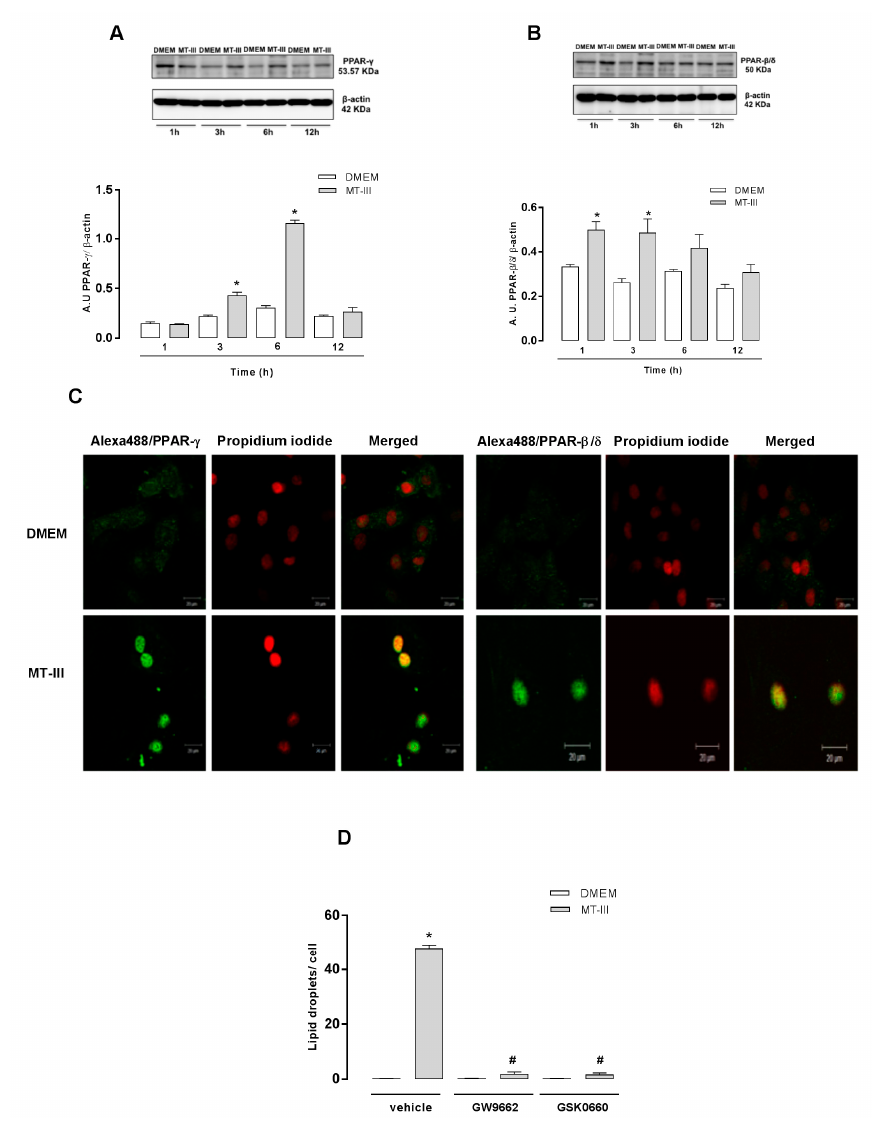
Figure 6. MT-III induces activation and upregulation of PPAR- γ and PPAR- δ / β expression in VSMCs. VSMCs (5 × 10 4 cells / well) were stimulated with MT-III (0.4 µ M) or DMEM (control) for 1, 3, 6, and 12 h. ( A , B ) Western blotting and densitometric analysis of PPAR- γ or PPAR- δ / β and β -actin (loading control) in VSMC extracts. The densities were normalized with those of β -actin. ( C ) VSMCs (8 × 10 3 cells / coverslip) incubated with DMEM (control) or MT-III (0.4 µ M) for 1 or 3 h were labeled with anti-PPAR- γ or PPAR- δ / β and visualized with a secondary antibody conjugated to Alexa488 (green). The nucleus was stained with iodide propidium. The pictures prove an activation and translocation of the PPARs to the nucleus. Shown pictures are representative of three independent experiments. ( D ) VSMCs (8 × 10 3 cells/coverslip) were incubated with GW9662 or GSK0660 (10 µM) PPAR inhibitors for 1 h and then stimulated with MT-III (0.4 µ M) for 12 h. LDs were quantified using light microscopy subsequent to osmium staining. Each bar represents the mean ± SEM LDs / cell in 50 counted cells from three independent experiments ( n = 9) (ANOVA). Note: * p < 0.05 compared with vehicle treated cells; # p < 0.05 compared with vehicle treated cells incubated with